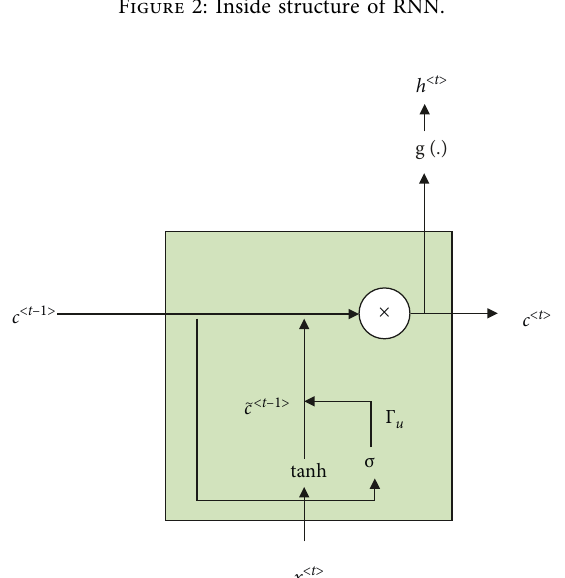
Figure 2: Inside structure of RNN.